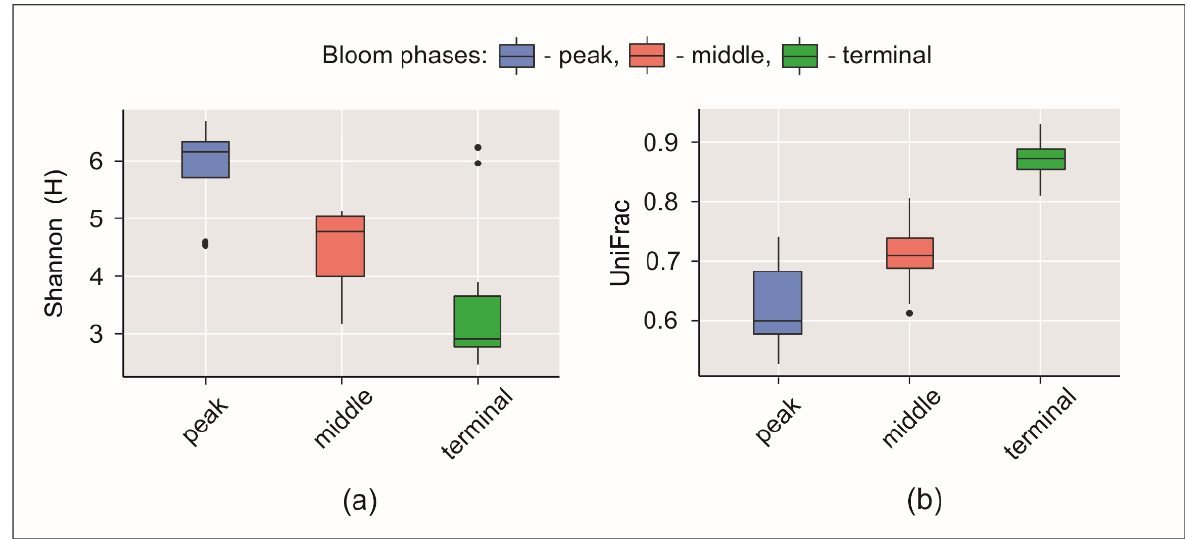
Figure 7. Temporal dynamics of the microbial biodiversity indices during summer HAB in Lake Imandra in 2017. Shannon (H) a — diversity index ( a ), UniFrac β— diversity index ( b ).